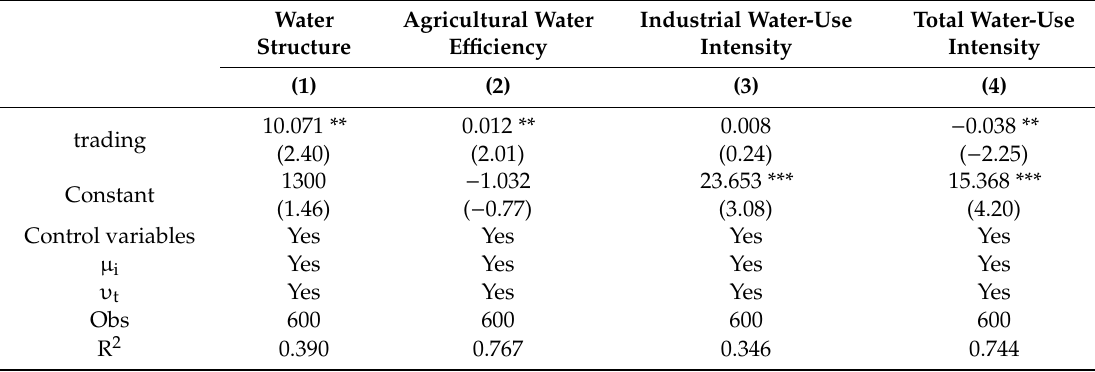
Table 4. The results for the influence